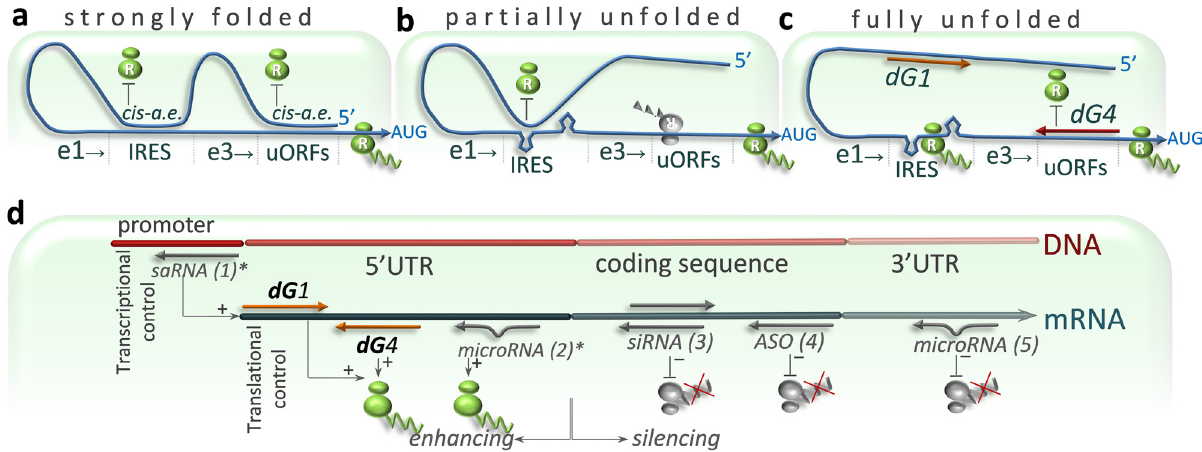
Fig 3. Folding states of TR β 1 5 ’ UTRs. Translation efficiency of TR β 1 is dependent on folding states of its 5'UTR, which is proposed to be: strongly folded ( a ), partially unfolded ( b ) or fully unfolded following interaction with dG1 and dG4 ( c ). The 5 ’ UTR is shown as curve ended by an arrow at AUG translation start codon. Two linked ovals assigned by letter R represent ribosome that may be blocked by distant cis -acting element ( cis -a.e) or trans -acting factor (dG1 or dG4). AUG start codon is preceded by selected translation-regulating elements (e1 and e3). Translation-enhancing element e1 contains putative Internal Ribosome Entry Site (IRES) that may be involved in enhancement of cap- independent translation initiation. Translation-silencing element e3 contains upstream Open Reading Frames (uORFs) – rich region that can reduce translation initiation from correct AUG start codon due to simultaneous synthesis of truncated proteins originated from upstream AUGs (shown by inverted ribosome). a , Theoretical folding state of TR β 1 5'UTR characterized by the presence of highly-structured sequence that can block both: translation-enhancing e1 and translation-silencing e3, finally leading to only basal protein synthesis. ( b ) Another theoretical folding state described by partially unfolded 5 ’ UTR with blocked e1 and unblocked e3, resulting in basal translation rates as well. ( c ) Proposed model of dG1 and dG4 -mediated enhancement of translation efficiency, wherein antisense dG4 could lead to repression of uORFs within e3, whereas binding of sense dG1 to a distant sequence (usually folded with e1) could release this translation- enhancing region, allowing for protein over-expression (additional description is given in S4 Fig). ( d ) dGoligo (dG) targets on mRNA. Locations of dG binding sites are shown in the context of typical targets of the most known small interfering RNAs. microRNA (2, 5), siRNA (3), saRNA (1) and ASO (4), are shown by short grey arrows. Newly described interactions that may result in up-regulation of gene expression are indicated by asterisk *